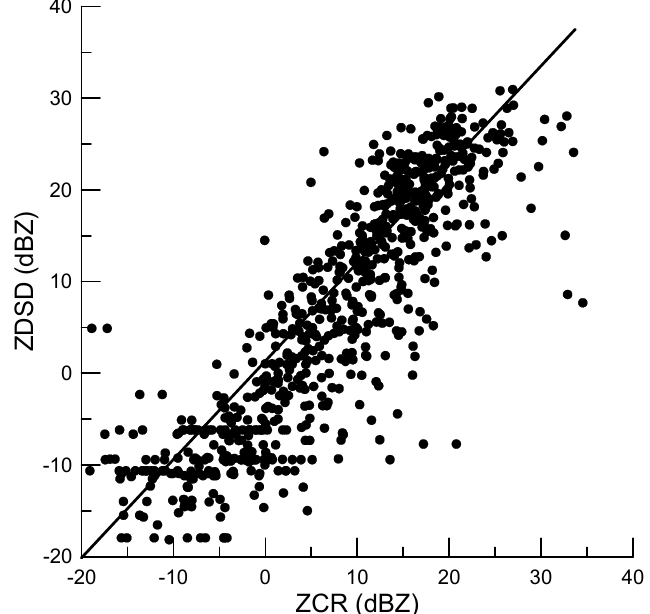
Figure 2. Scattering figure of minutely averaged reflectivity at the height of 300 m by CR (ZCR) and the reflectivity calculated based on the DSD data (ZDSD) for 24 July and 14 July.